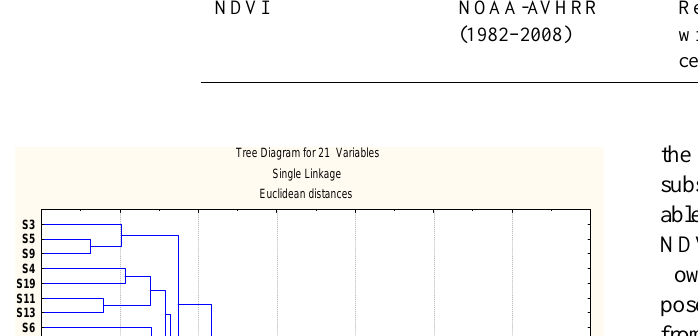
Figure 5 Projection of cases from the PCA of variables